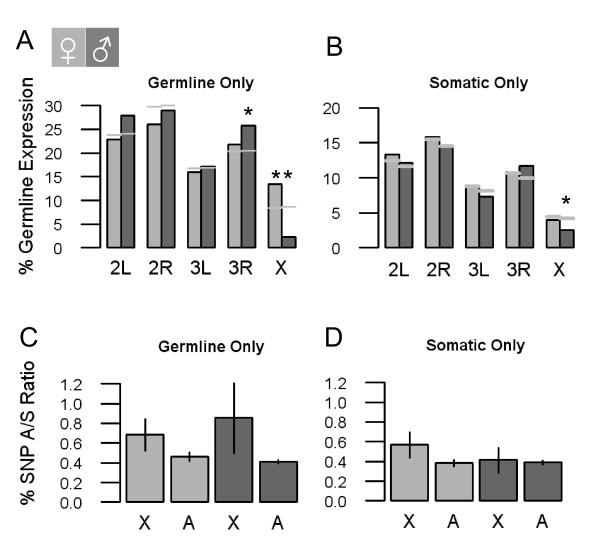
Gene expression for major chromosome arms. (A) Germline only expression; testis (blue), ovary (red). (B) Somatic only expression; male (blue), female (red). (C) Germline only X vs autosomal SNP A/S ratio. (D) Somatic only X vs autosomal SNP A/S ratio. (Chi-squared Test; *P < 0.05). Grey bars represent expected proportions. 95% C.I. was estimated with 10,000 bootstrapped replicates.